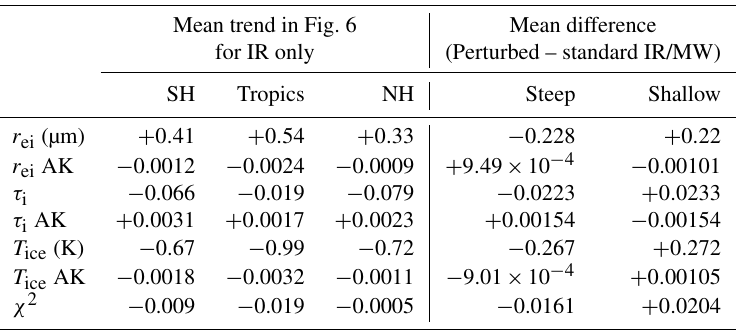
Table 2. T4he trends depicted in Fig. 6 for the IR only retrieval, and the radiance perturbation sensitivity tests that adjust the slope in the retrieval channels. The “steep” category indicates a steeper slope with retrieval channel 1 at 692.76cm − 1 perturbed 50mK cooler, retrieval channel 59 at 1133.91cm − 1 perturbed 50mK warmer, and a linear interpolation in between (see K14 for a list of the 59 retrieval channels). The “shallow” category is reversed from the “steep”